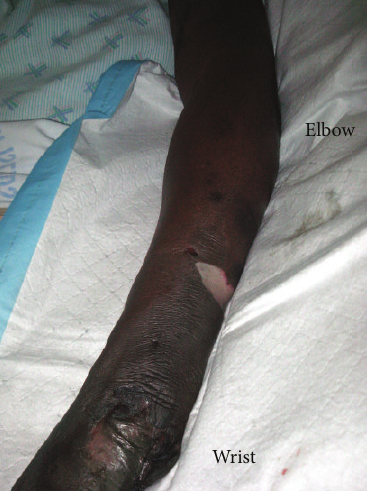
Figure2:Clinicalphotographoftheleftupperlimbofapatientwith dry gangrene to the midforearm level. Note the presence of blebs in the midforearm and distal forearm.